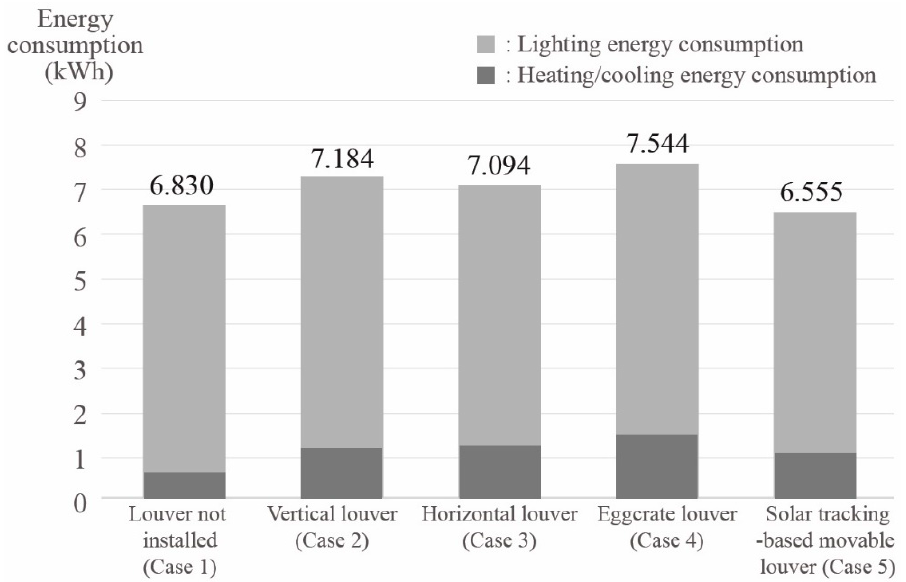
Figure 15. Lighting and heating/cooling energy consumption based on the optimal specifications of each case for saving energy.